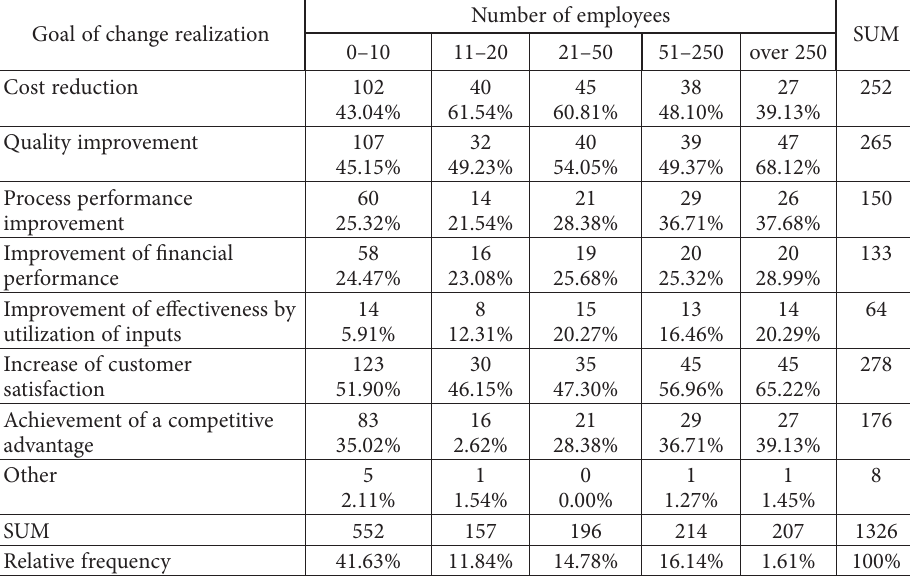
Table 1. Pivot table for enterprise size and goal of change (source: own processing) Goal of change realization